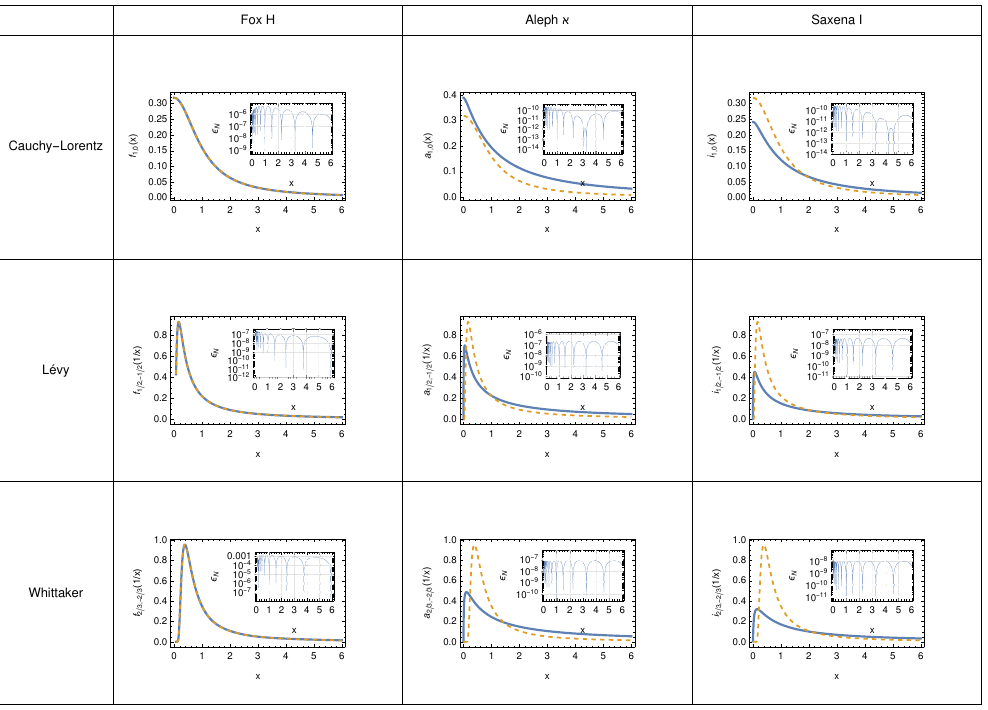
Figure 17. Three one sided stable distributions and their Aleph and Saxena variants. The number of Sinc points in all approximations is N =